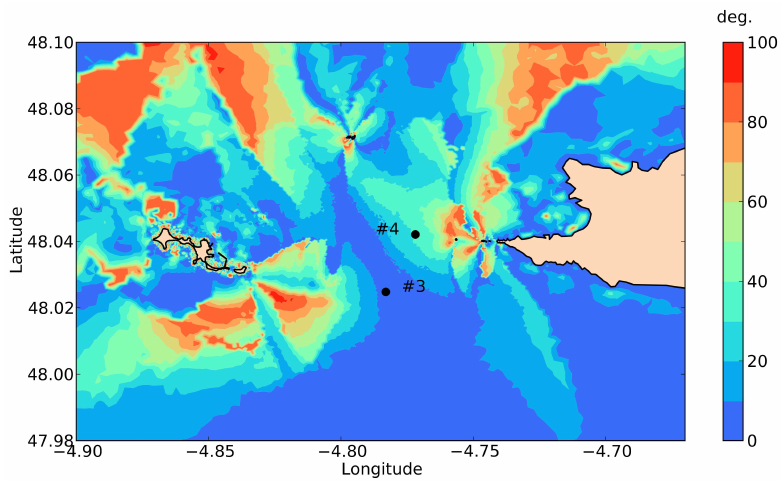
Figure 9. Averaged misalignment direction θ between tidal stream power peaks in ebb and flood over a year. The black circles show the locations of points #3 and #4.